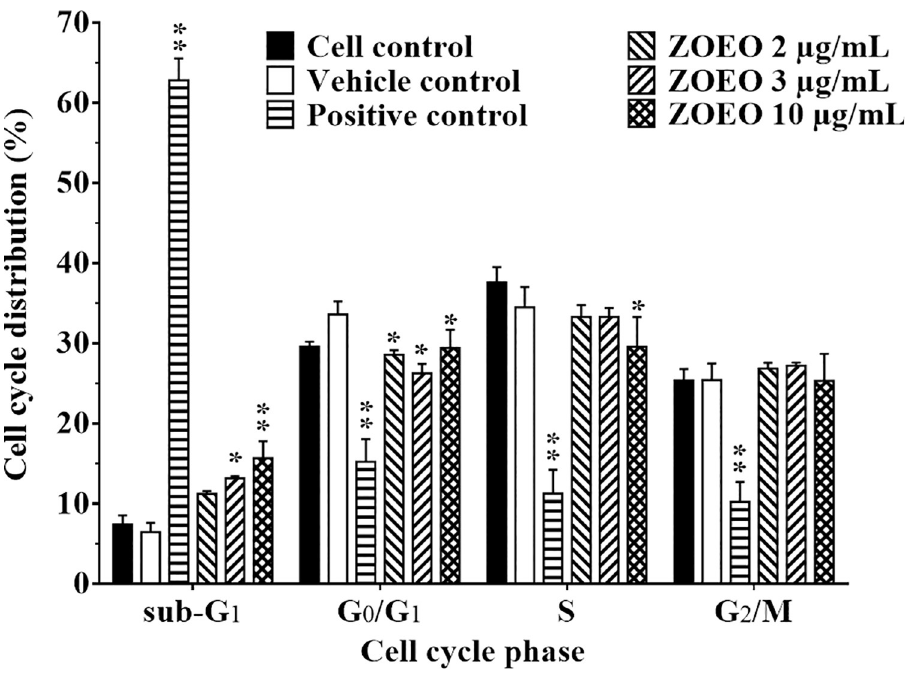
Fig 4. Representative bar graph of cell cycle phases of MCF-7 cells after 48 h exposed to various concentrations of ZOEO in comparison with the controls. Each bar represents mean ± SD of three independent experiments performed in triplicate. Asterisk ( � ) denotes significant differences from vehicle control; � p < 0.05; �� p < 0.001. The dataset is available in S6 Table.